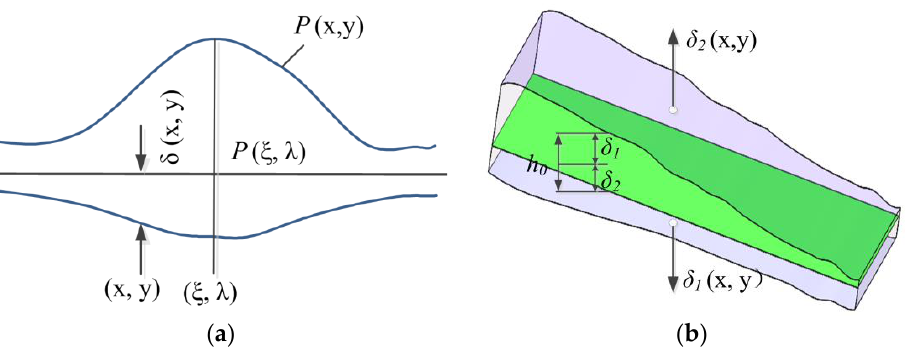
Figure 2. The EHL model for point and surface contact. ( a ) Elastic deformation of point contact; ( b ) elastic deformation of surface contact.